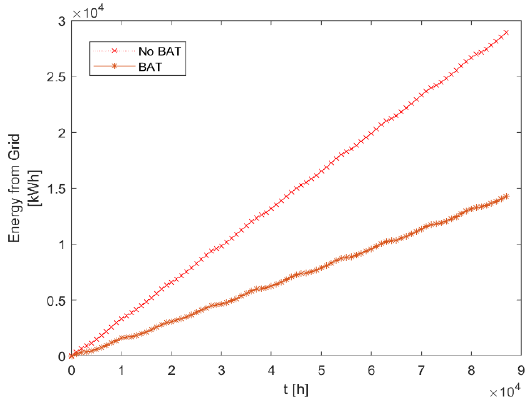
Figure 13. Energy request from the grid (Location 2).